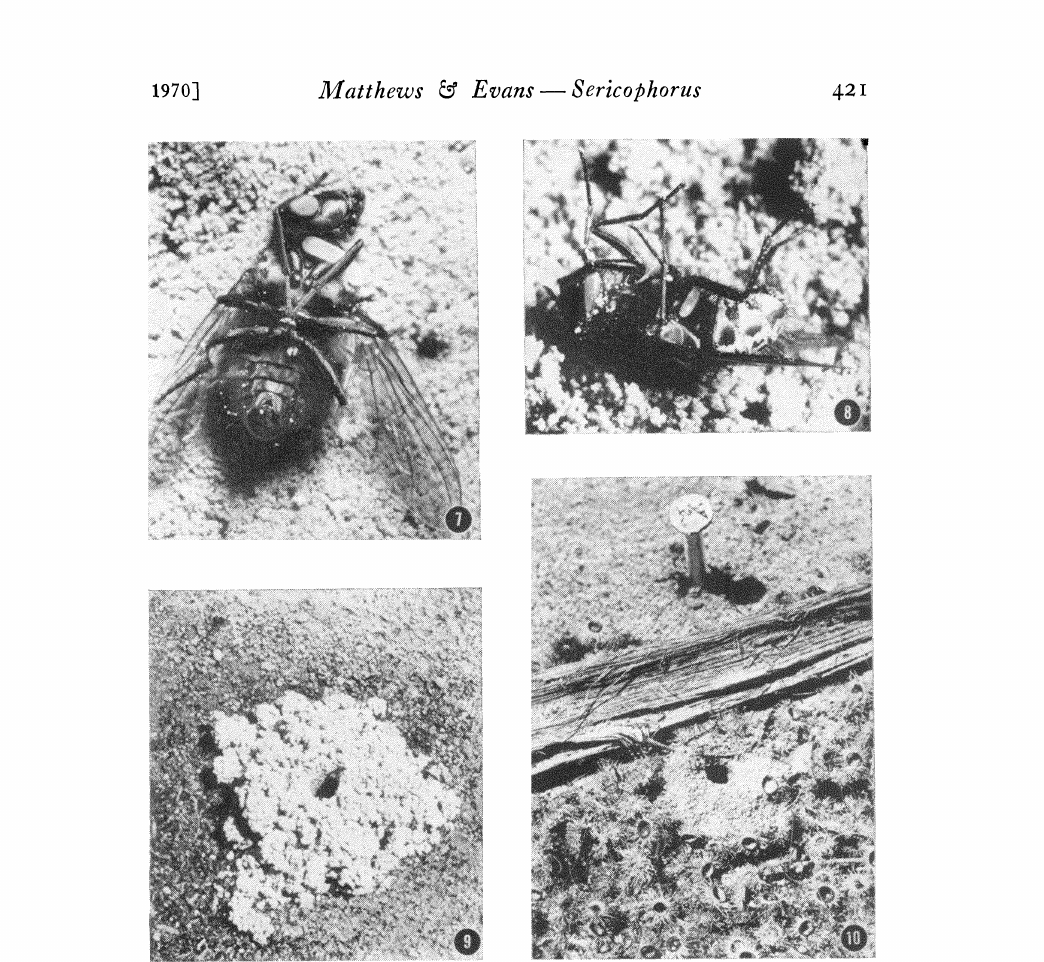
Fig. 7. Egg of Sericophorus iridis on prey, a male Calliphora tibialis. Fig. 8. Egg of the parasitic wasp, /lcanthostethus portlandensis, on a Calliphora tibialis from a nest of Sericophorus iridis. Fig. 9. Typical nest entrance of ,7..viridis, Canberra, A. C. T. Fig. 10. Nest entrance of S. relucens, AM 122, near Peak Hill, N. S. W. Debris from Eucalyptus infloreseenees has accumulated on the lee side of a stick; a nail used as a nest marker is above the